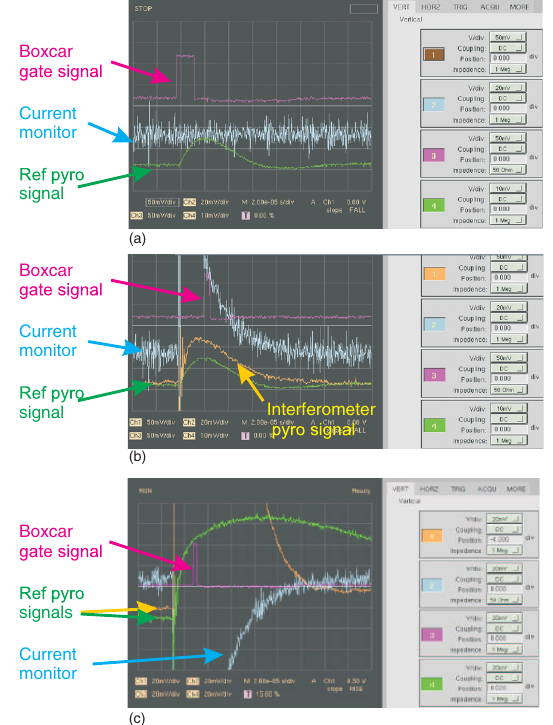
FIG. 13. Oscilloscope signals with no breakdowns (a), a breakdown that generated a positive signal (b), and a breakdown that generated a negative signal